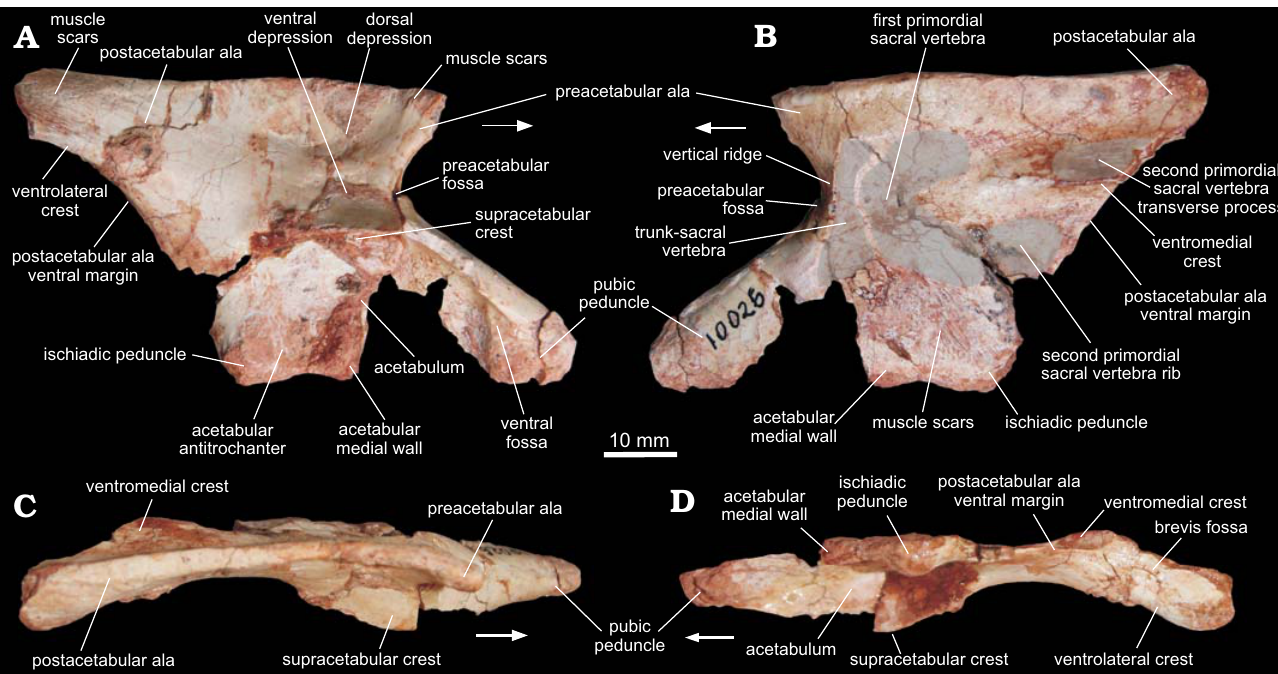
Fig. 4. Right ilium of a sauropodomorph from Sacisaurus site, Late Triassic Caturrita Formation, Agudo, Rio Grande do Sul, Brazil; MCN PV10026 in lateral ( A ), medial ( B ), dorsal ( C ), and ventrocaudal ( D ) views. Arrows point to